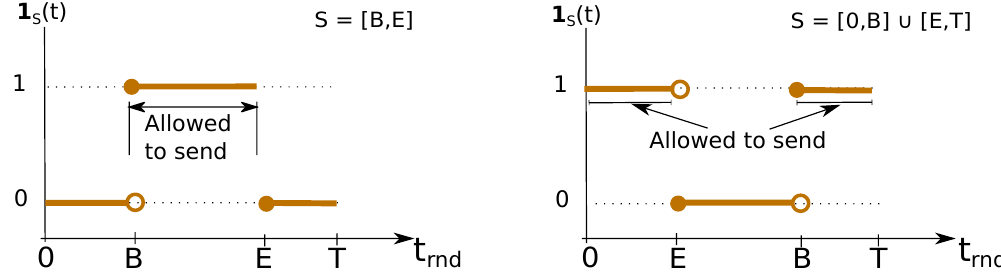
Figure 4. A TDMA transmission slot S is defined by its boundaries B and E . A node is allowed to